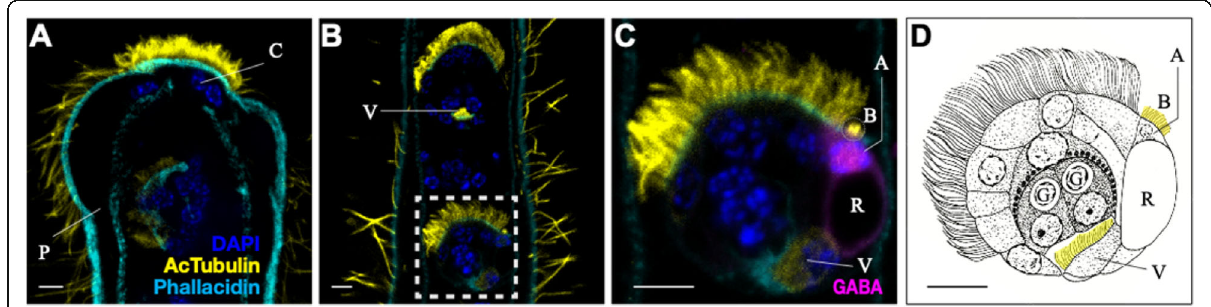
Fig. 5 Various types of cilia and existence of bristles on Dicyema japonicum . a In the anterior end of a rhombogen, cilia on the calotte cells are shorter and denser than those on other peripheral epithelial cells. b Ventral internal cells of infusoriform larva bear short cilia forward to urn cavity. A dashed square encloses an infusoriform embryo inside the central axial cell of a rhombogen adult. The density of cilia on epithelial cells of the infusoriform larva is higher than on epithelial cells of the rhombogen adult, reflecting higher mobility of larvae. c An infusoriform embryo, enlargement of the dashed square of ( b ). The length of bristles on apical cells of the infusoriform larva is approximately one-third that of cilia on epithelial cells. Immunostaining signals of GABA appear in apical cells. d Sagittal optical section of an infusoriform larva. Yellow labels bristles and cilia on ventral internal cells, respectively. Adapted and modified from Furuya et al. (1992). A, apical cell; B, bristles; C, calotte cell; G, germinal cell; P, peripheral epithelial cell; R, refringent body inside apical cell; V, ventral internal cell of infusoriform larvae. Scale bars: 20 μ